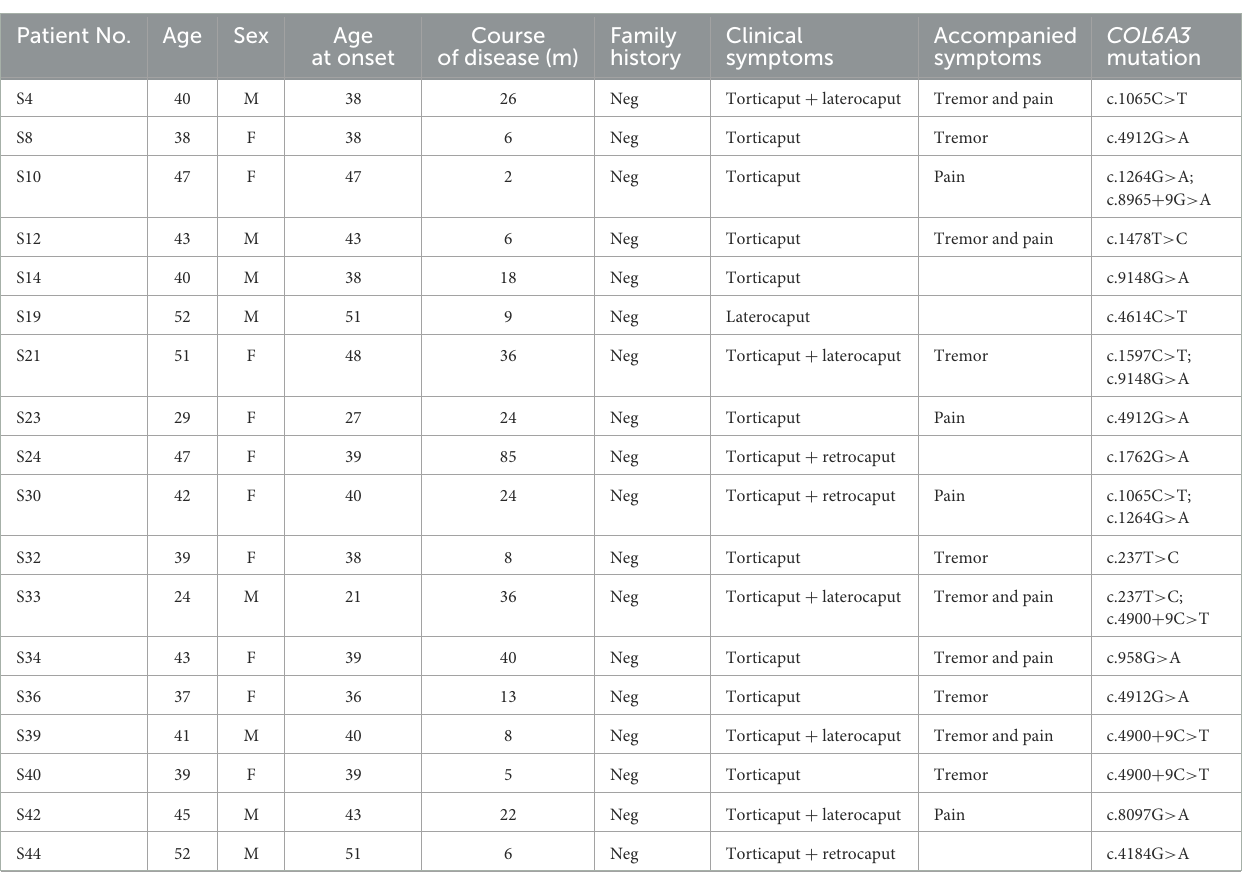
TABLE 1 Phenotypic profile of 18 patients with COL6A3 mutation. Patient No.